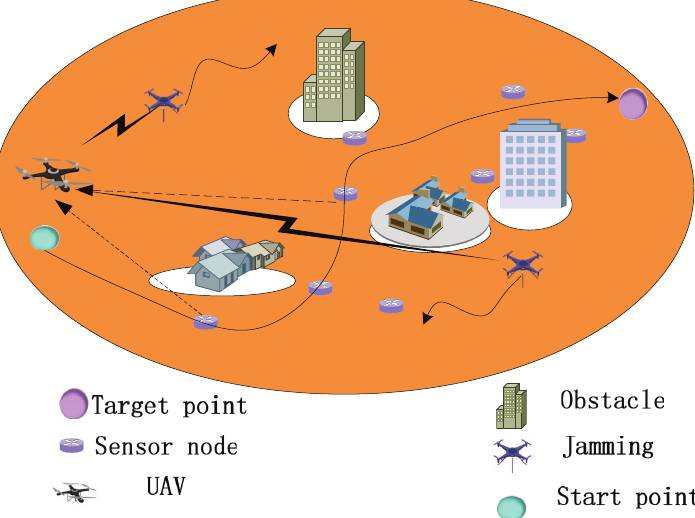
Figure 1. UAV-aided Data Collection with Dynamic